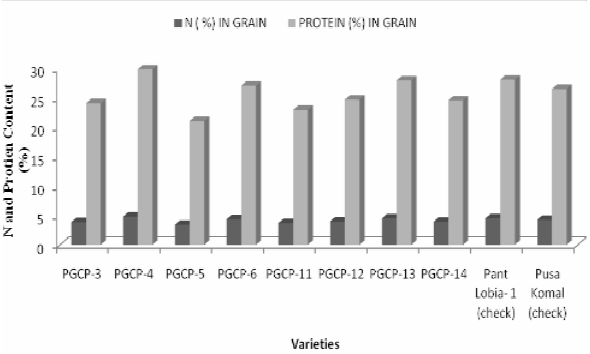
Fig.2. Nitrogen and protein content in cowpea grains as influenced by cultivar differences The dehydrogenase activity of soil ranged from